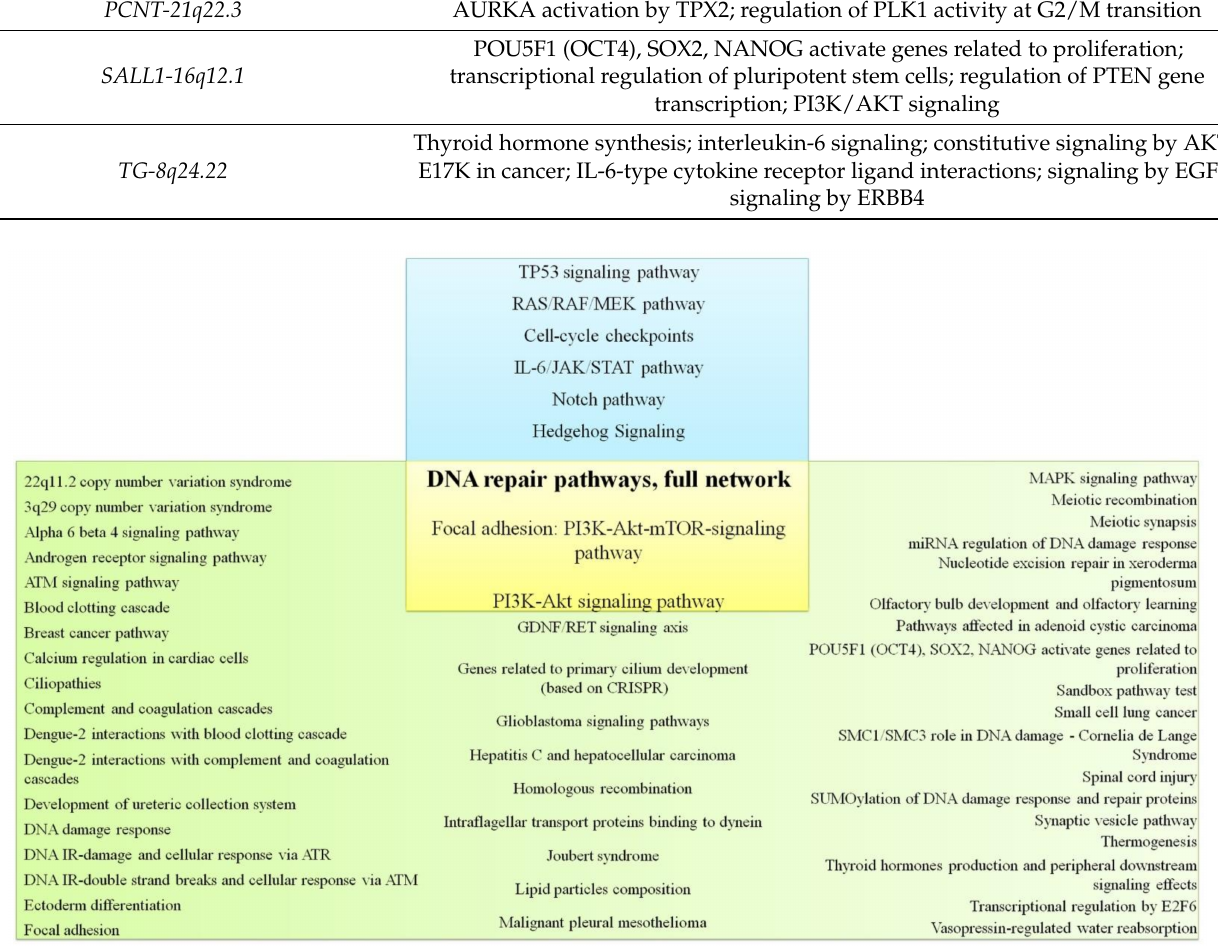
Figure 2. Signaling pathways for TNBC according to the literature data and signaling pathways determined by genes with mutations that are found in TNBC but not in non-TNBC according to TCGA